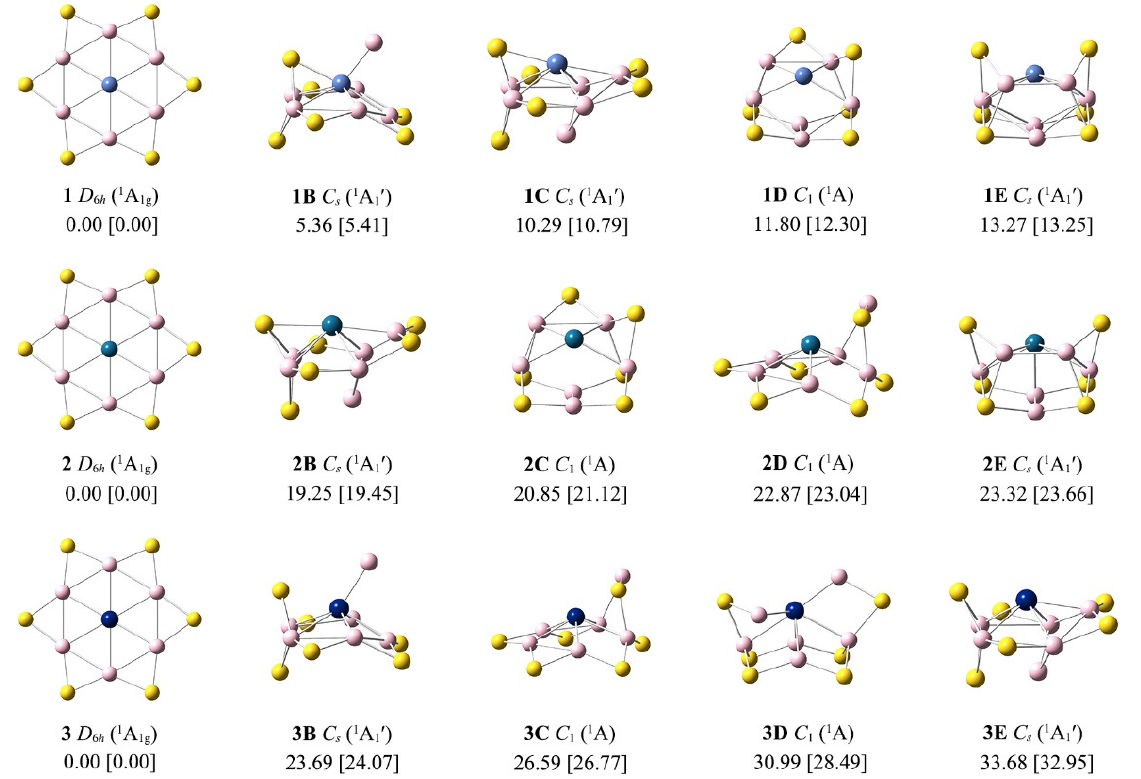
Figure 2. Optimized GM structures 1 – 3 of the MAl 6 S 6 (M = Ni, Pd, Pt) clusters at the PBE0/def2- TZVP level, along with their four lowest-lying isomers ( n B – n E ). Relative energies are listed in kcal mol − 1 at the single-point CCSD(T) level using their PBE0 geometries, with zero-point energy (ZPE) corrections at PBE0. Shown in square brackets for comparison are the energetics at single-point CCSD(T)/def2-TZVP//B3LYP/def2-TZVP level, including ZPE corrections at B3LYP.